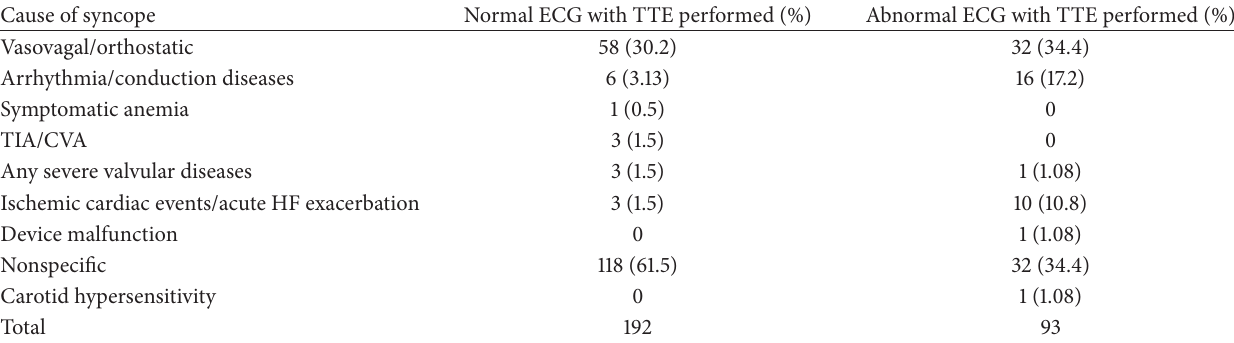
Table 3: Causes of syncope in normal and abnormal ECG groups with TTE performed. Cause of syncope Normal ECG with TTE performed (%) Abnormal ECG with TTE performed